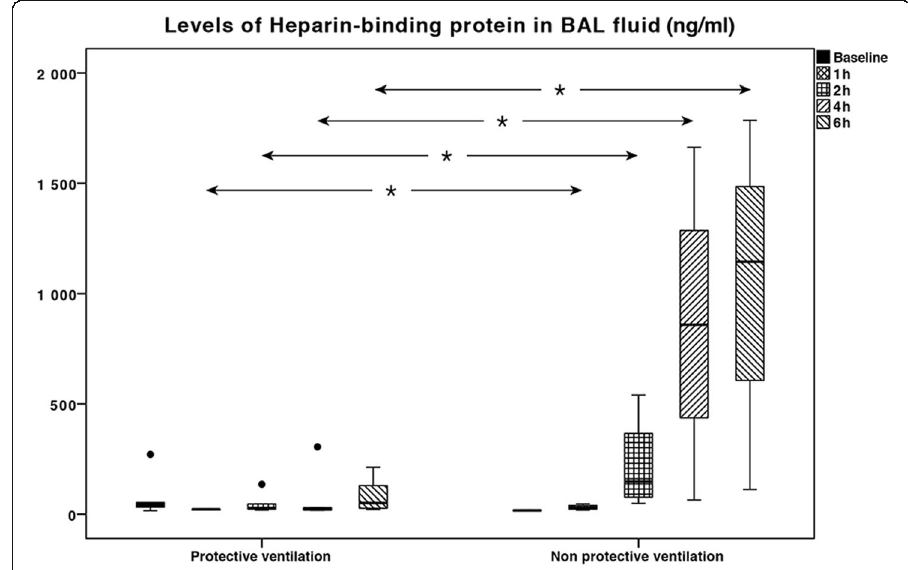
Fig. 2 Levels of heparin-binding protein (HBP) (ng/ml) in the bronchoalveolar lavage (BAL) fluid from pigs. HBP levels were significantly higher in the group receiving harmful ventilation at 2 h ( p =0.03), 4 h ( p <0.01), and 6 h ( p =0.02) of ventilation. Boxes indicate the second to third quartile with the median. Brackets indicate min-max values, circles indicate outliers, and stars indicate significant differences ( p